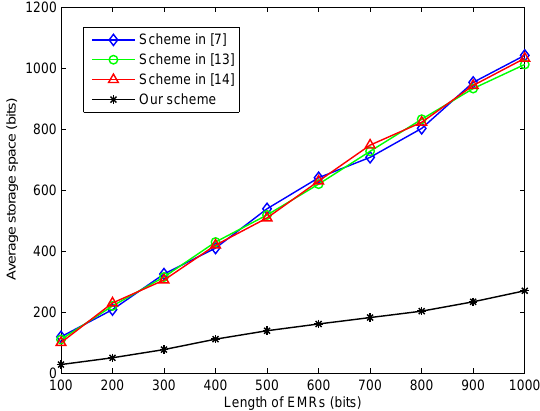
Figure 5. The average storage space for different lengths of EMRs.